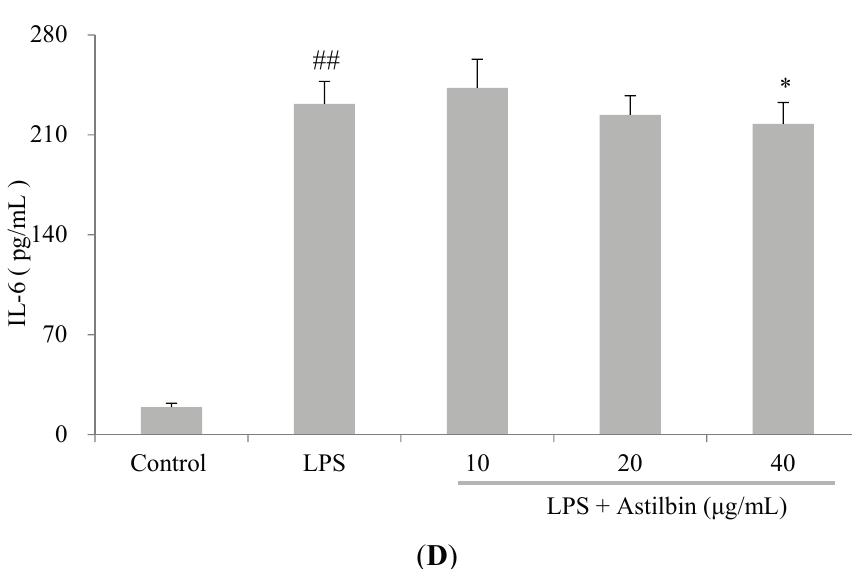
Figure 2. Effects of astilbin on cell viability ( A ) and the production of NO ( B ), TNF- α ( C ), and IL-6 ( D ) in LPS-induced RAW264.7 cells. (A) Cells were treated with different concentrations (10, 20, and 40 µg/mL) of astilbin for 24 h. Cells viability was determined using MTT assay. Results were expressed as mean ± standard deviation (SD) from six independent experiments in each group. (B–D) Cells were incubated with varying concentrations of astilbin for 2 h, and then stimulated with LPS (0.1 µg/mL) for 20 h (for TNF- α and IL-6) or 24 h (for NO), respectively. Culture medium was tested for the production of nitrite, TNF- α and IL-6. The results are expressed as mean ± SD values (n = 3). ## p < 0.01 compared to the control group, while * p < 0.05 and ** p < 0.01 compared to the LPS-treated